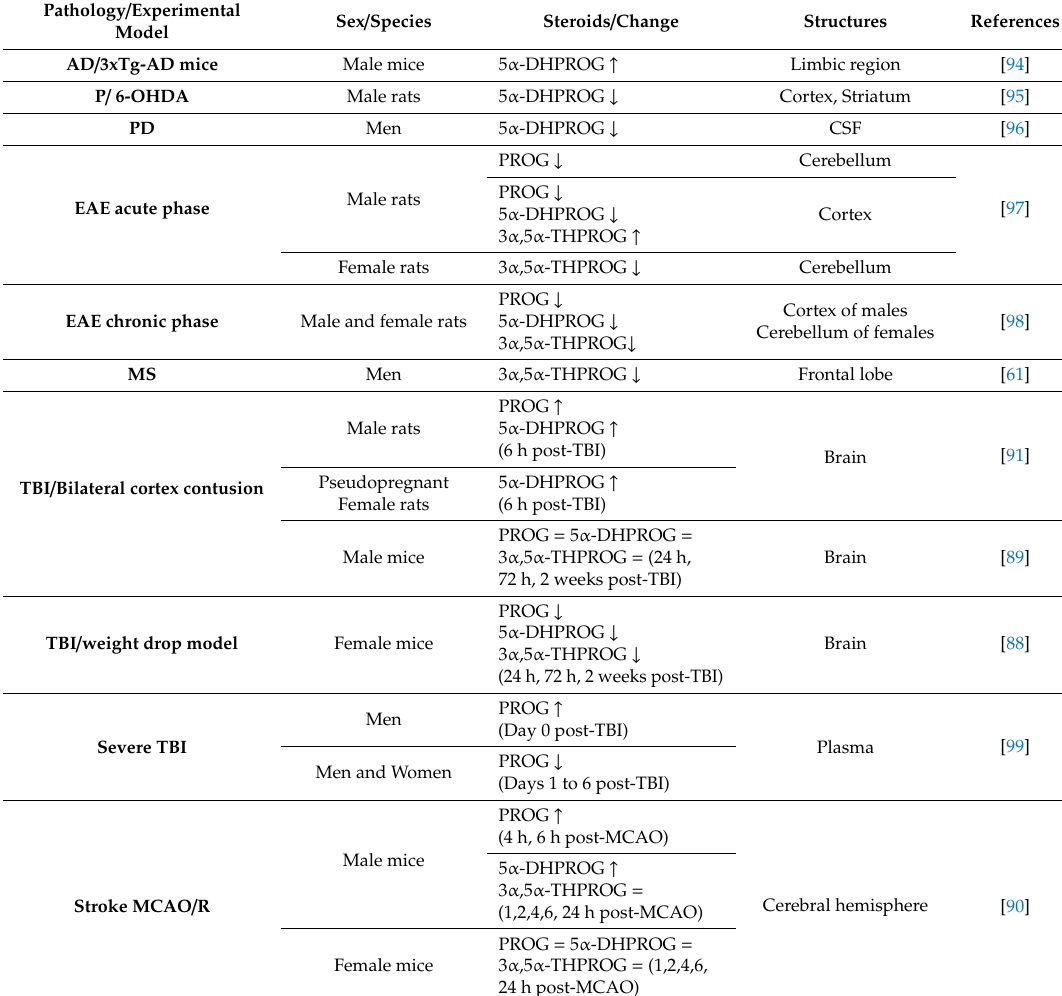
Table 2. Levels of progesterone (PROG), 5 α -dihydroprogesterone (5 α -DHPROG), and 3 α ,5 α -tetrahydroprogesterone (3 α ,5 α -THPROG) under neurodegenerative conditions and in response to brain